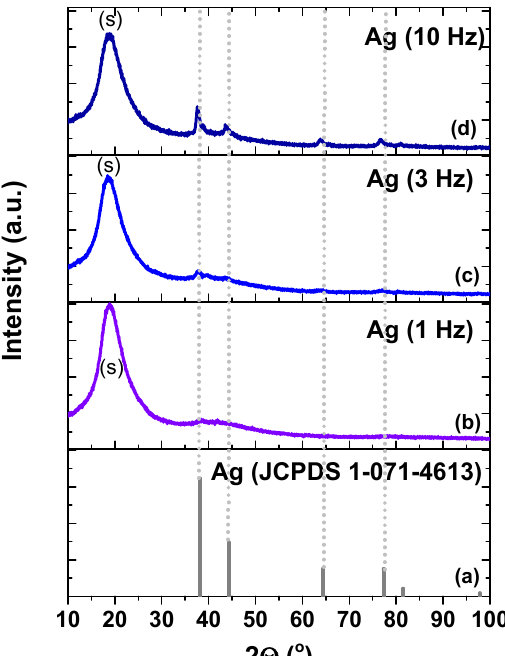
Figure 5. XRD spectra for the Ag thin films obtained at different pulse frequencies 1 Hz ( b ), 3 Hz ( c ), 10 Hz( d ). The position of Ag peaks in the JCPDS card is depicted in ( a ).